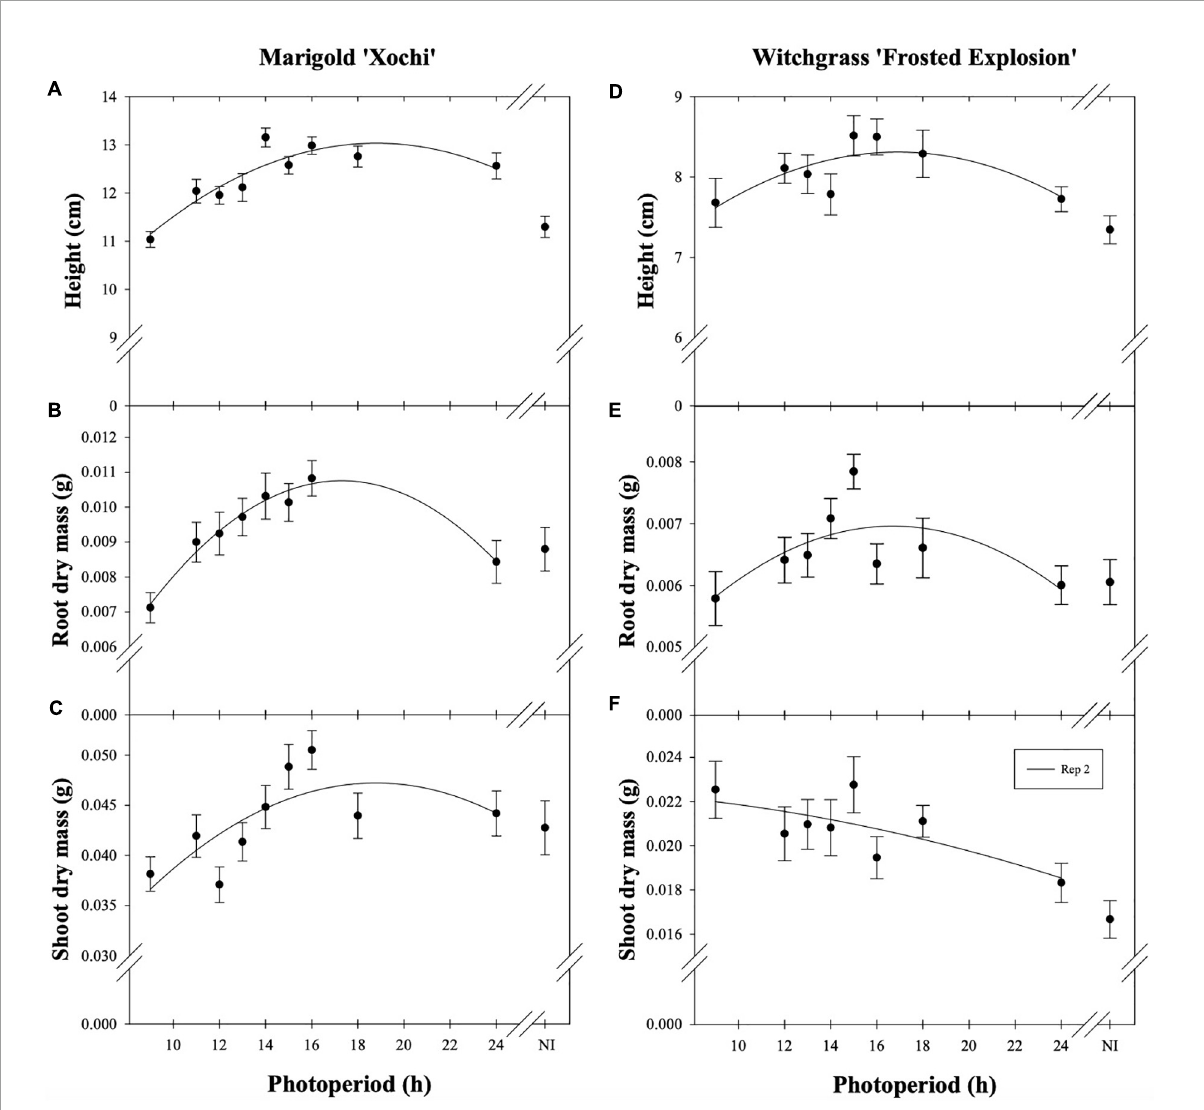
FIGURE1 Effect of photoperiod [9, 11, 12, 13, 14, 15, 16, 18, and 24 h, or a 4-h night interruption (NI)] on the height (A,D) , root dry mass (B,E) , and shoot dry mass (C,F) of marigold ‘Xochi’ ( Tagetes erecta ) and witchgrass ‘Frosted Explosion’ ( Panicum capillare ) young plants. Panel (F) presents data from replication 2 as trends from replication 1 were not significant. Coefficients are presented in Table 7